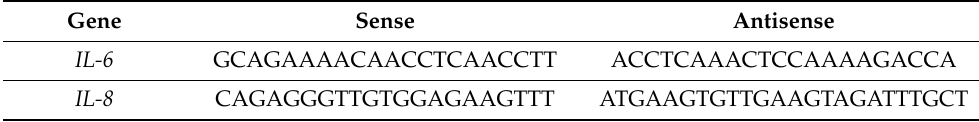
Table A1. Forward and reverse primer sequences for IL-6 and IL-8